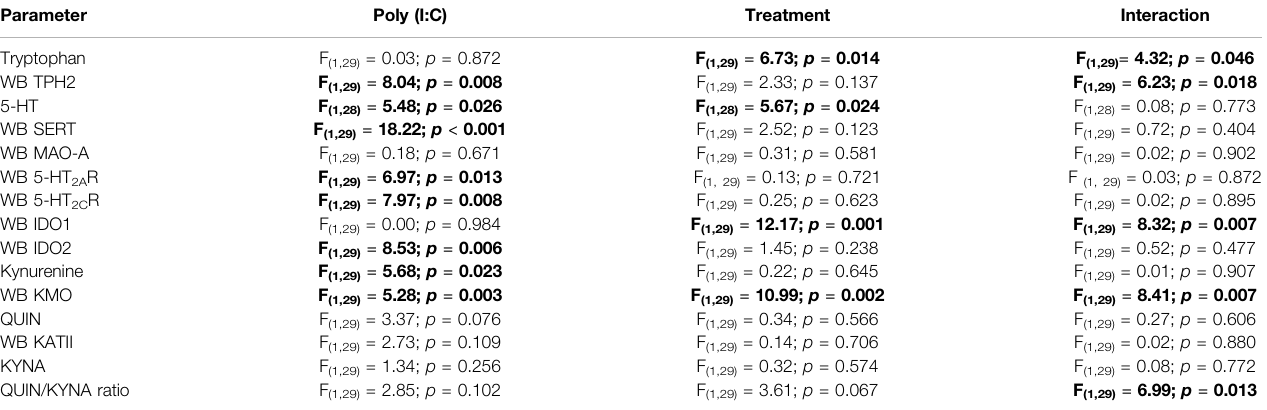
TABLE 1 | Two-way ANOVA analyses (F, df and p values) of protein expression and metabolites determination. Bold: statistically signi fi cant values. WB, western blot experiments. Parameter Poly (I:C) Treatment Interaction